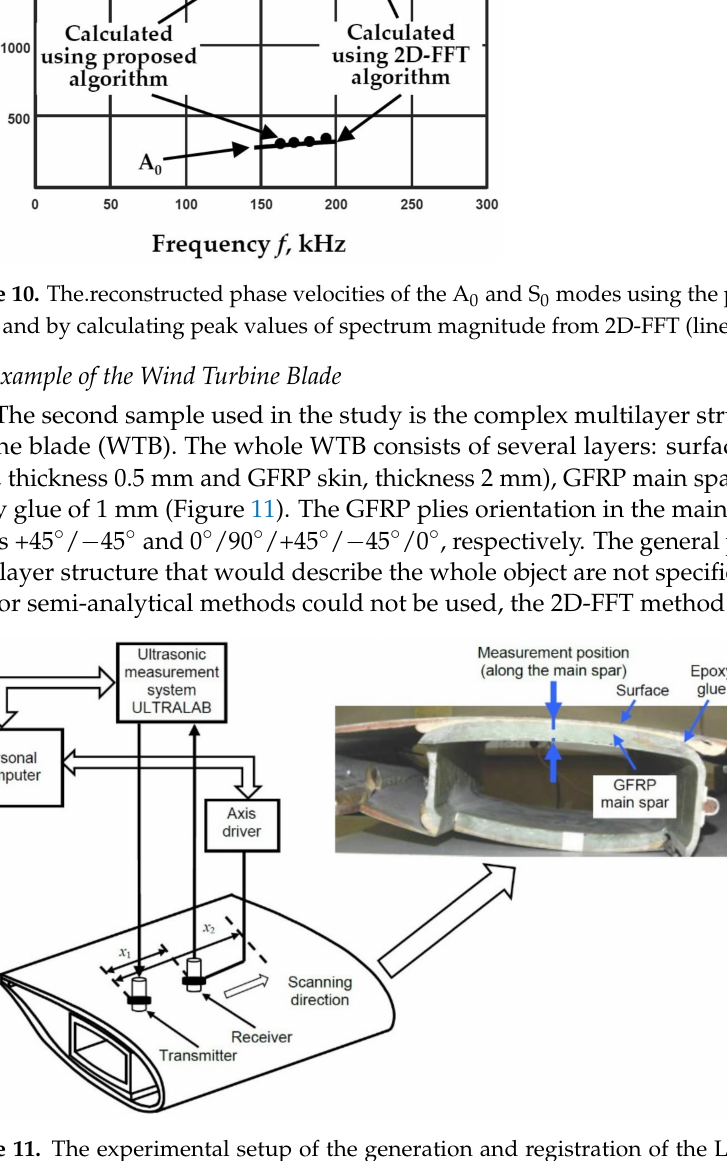
Figure 11. The experimental setup of the generation and registration of the Lamb waves signals propagating in a wind turbine